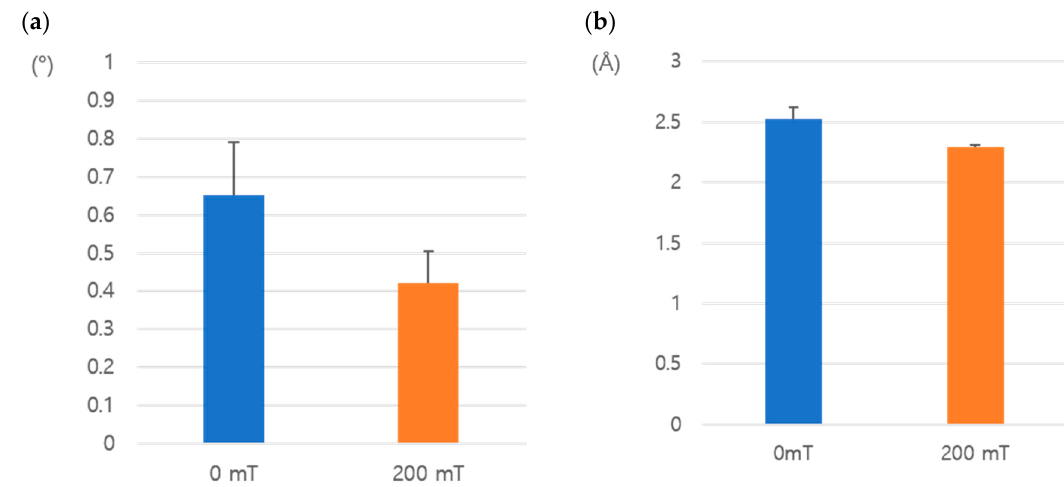
Figure 10. Comparison of the mosaicity and resolution of the ENR: ( a ) mosaicity; ( b ) resolution. The number of collected data sets of crystals grown under 0 and 200 mT are 14 and 15, respectively.